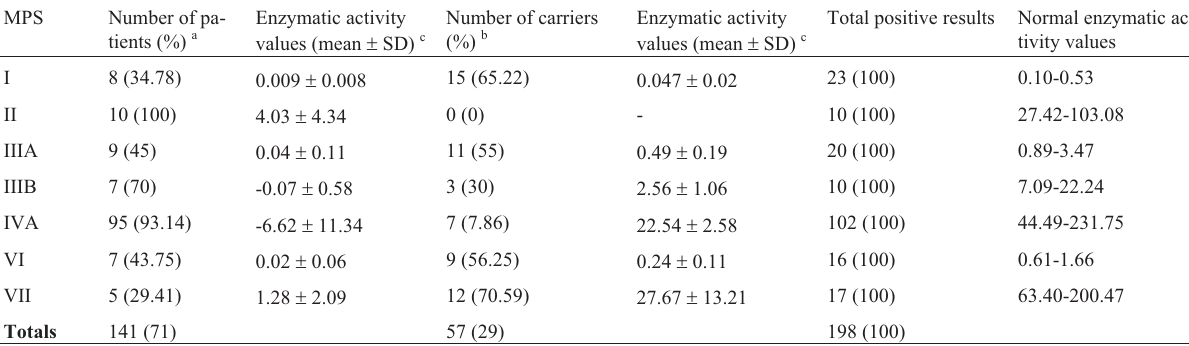
Table 4 - Enzymatic activity values of patients (expected homozygous) and carriers (expected